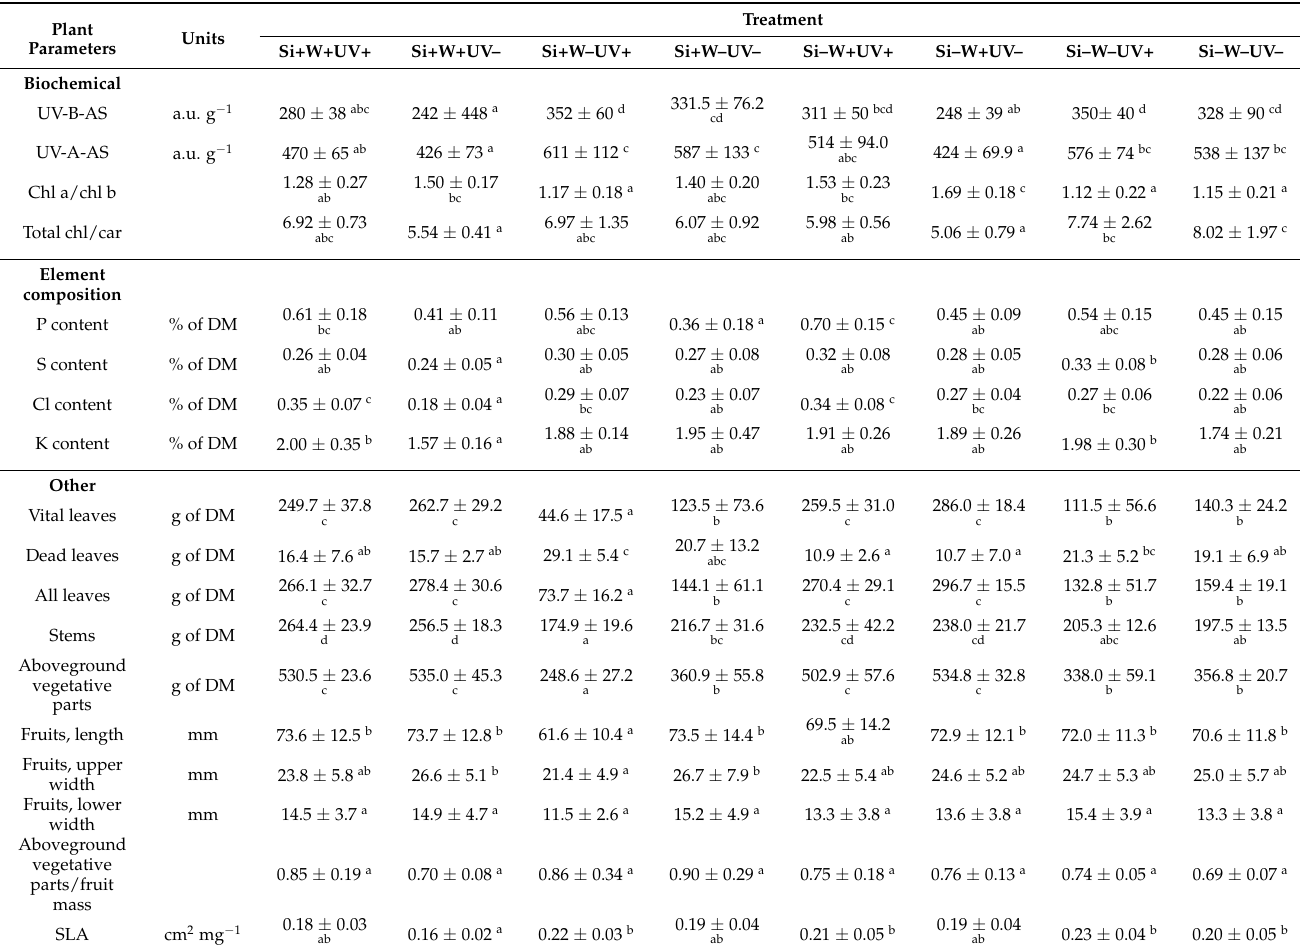
Table 1. Leaf biochemical traits, leaf element composition, and other traits for cucumber plants, grown under eight different